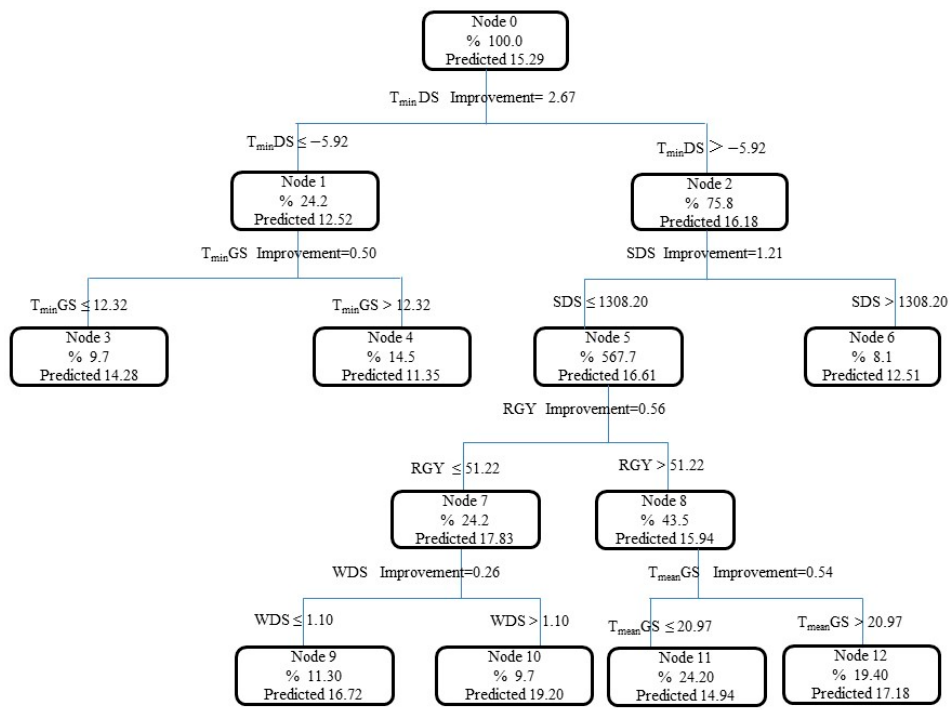
Figure 4. Climatic variables used for CART modeling carbon sequestration in ABM of P. schrenkiana in the Tianshan Mountains (CART: classification and regression tree model; ABM: above ground biomass).